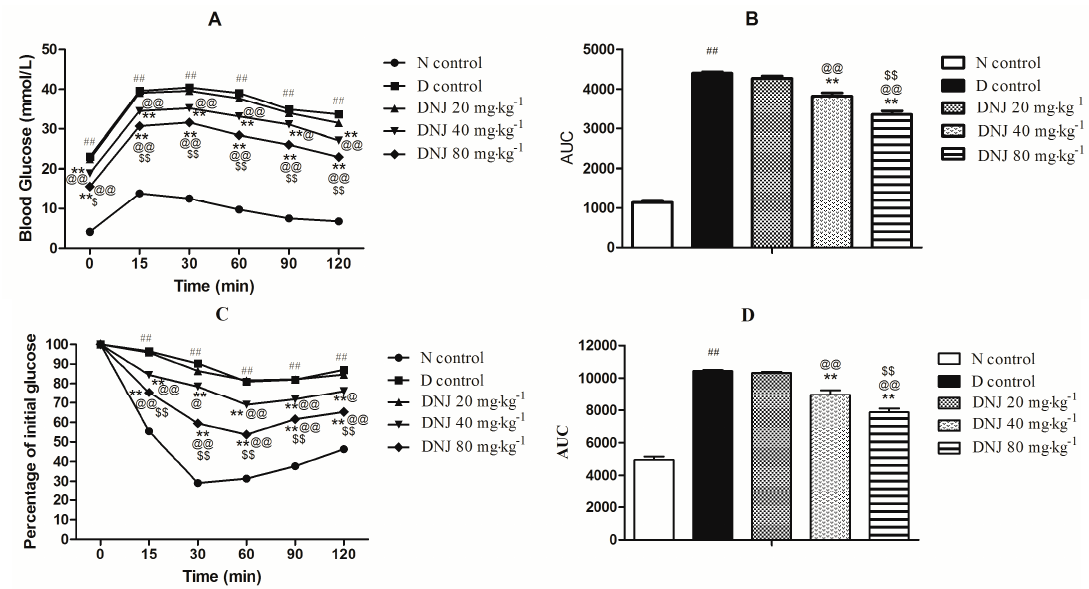
Figure 5. Intraperitoneal Glucose Tolerance Test (IPGTT) ( A ) and Intraperitoneal Insulin Tolerance Test (IPITT) ( C ) were determined, and Area under the curve (AUC) levels of IPGTT ( B ) and IPITT ( D ) were calculated. ## p < 0.01 vs. N control; ** p < 0.01 vs. D control; @ p < 0.05, @@ p < 0.01 vs. DNJ